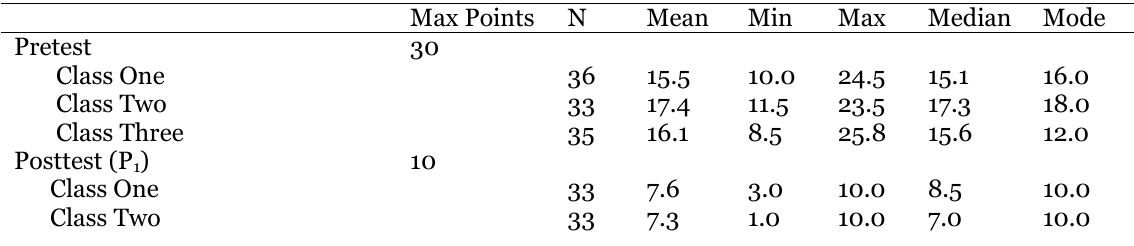
Descriptive Statistics for Pretest and